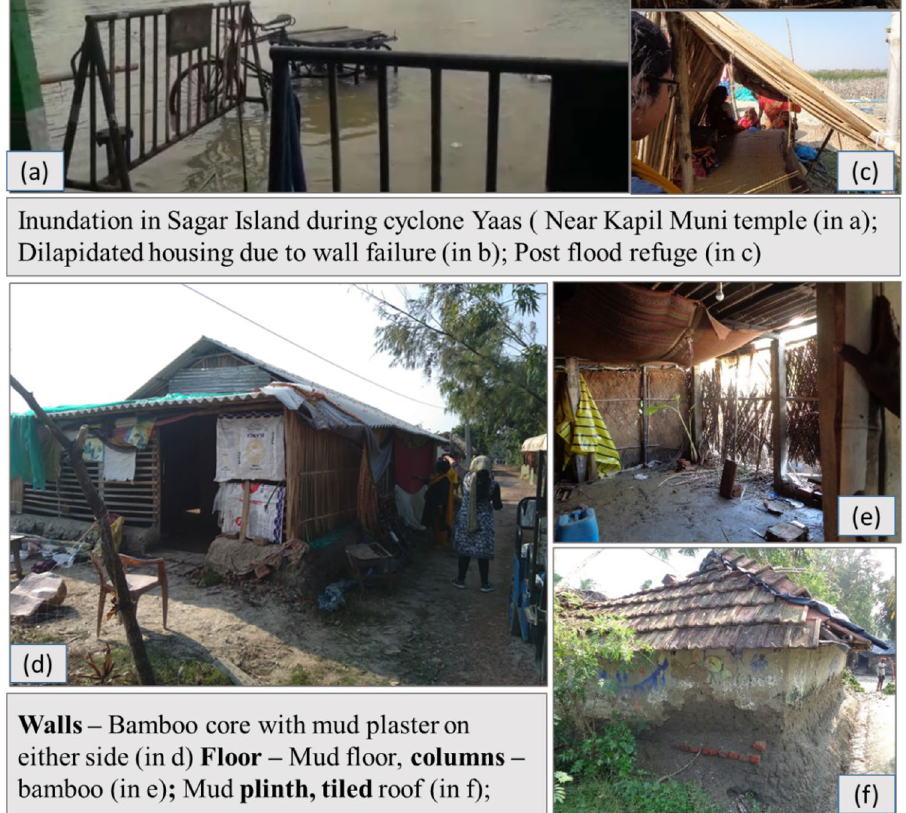
Figure 1. Inundation, post inundation scenario along with primary housing typology at